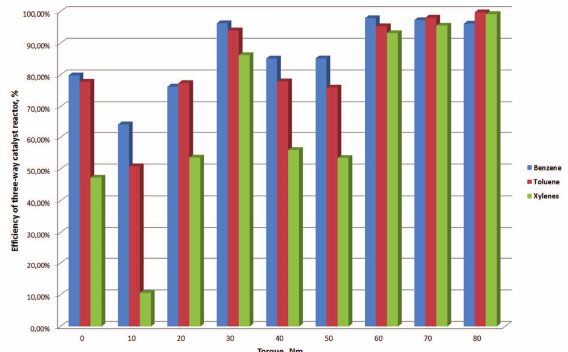
Table 2. Concentration (in µg/m 3 ) of BTX measured before and after catalyst reactor Torque, Nm